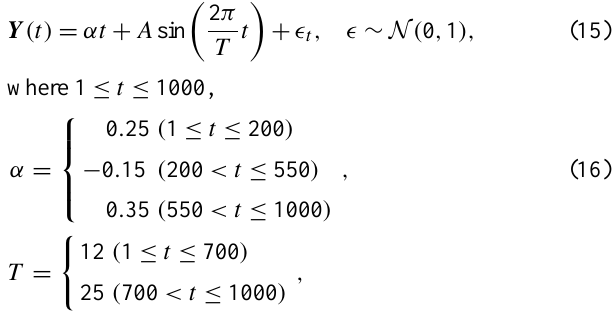
Fig. 7. w-correlation, (a) for the whole components for L SSA = 100 and (b) for the first 8 components.